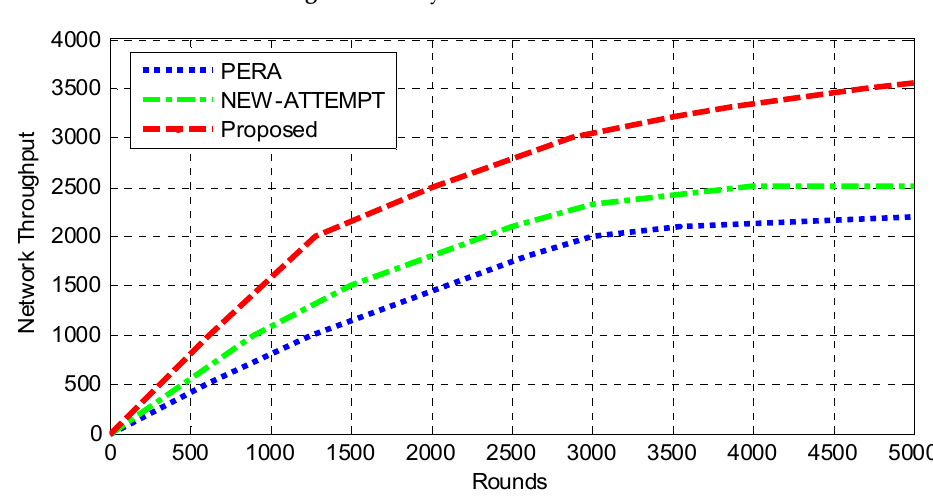
Figure 5. Analysis of network lifetime.